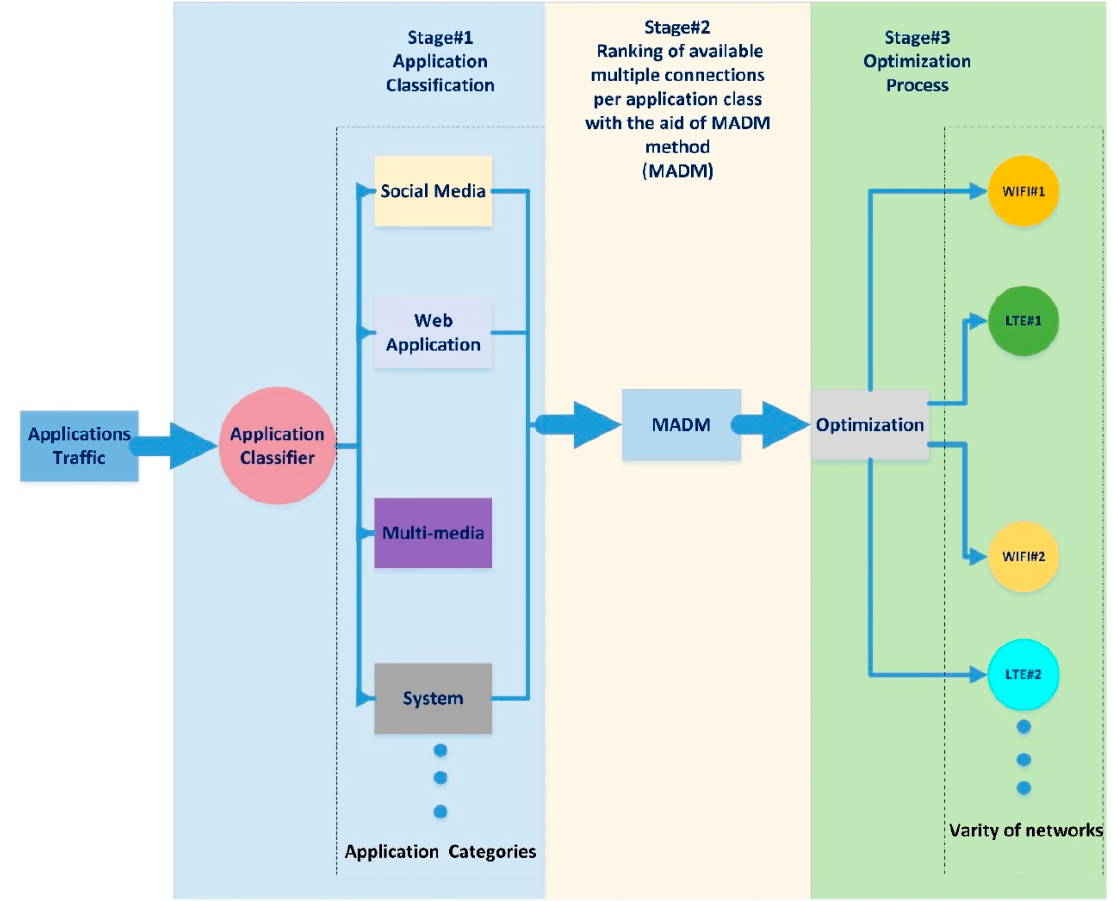
Figure 2. Illustration of the proposed system model.